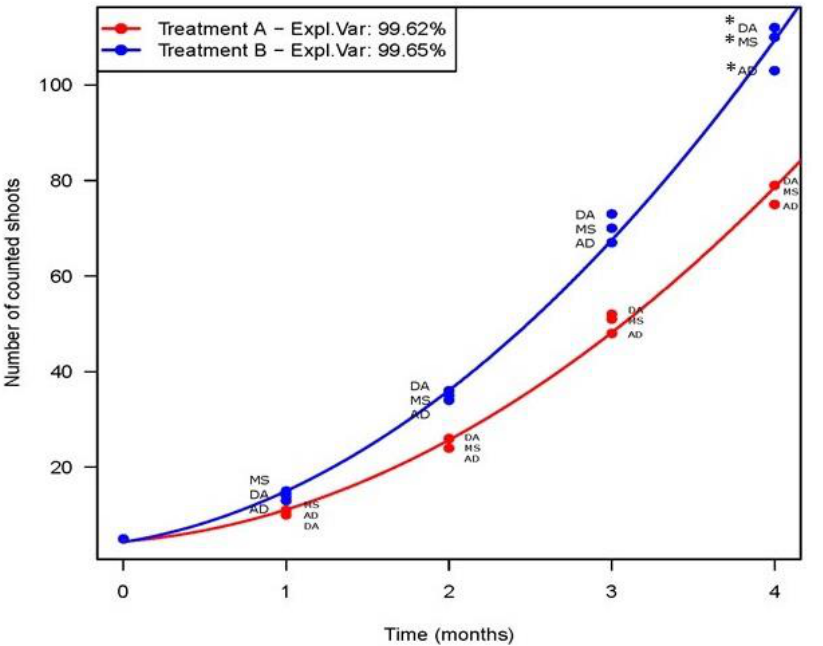
Figure 2. Predictive growth model of shoot multiplication. Data are cumulative number of shoots observed after the first, second, third and fourth subcultures from an initial lot of five shoots according to two different procedures of cultivation of three S. acmophylla ecotypes. MS: Mea Shearim; AD: Adom; DA: Darom. Treatment A: Continuous subculturing on BA-containing medium; Treatment B: Isolation of the shoot apex (first internode) and its culture on activated charcoal (0.2 mg L − 1 )- containing medium and culture of the underlying internode(s) on BA (5 µ M)-containing medium. Values were analyzed by χ 2 test; asterisks indicate a 5% significance level between treatments within